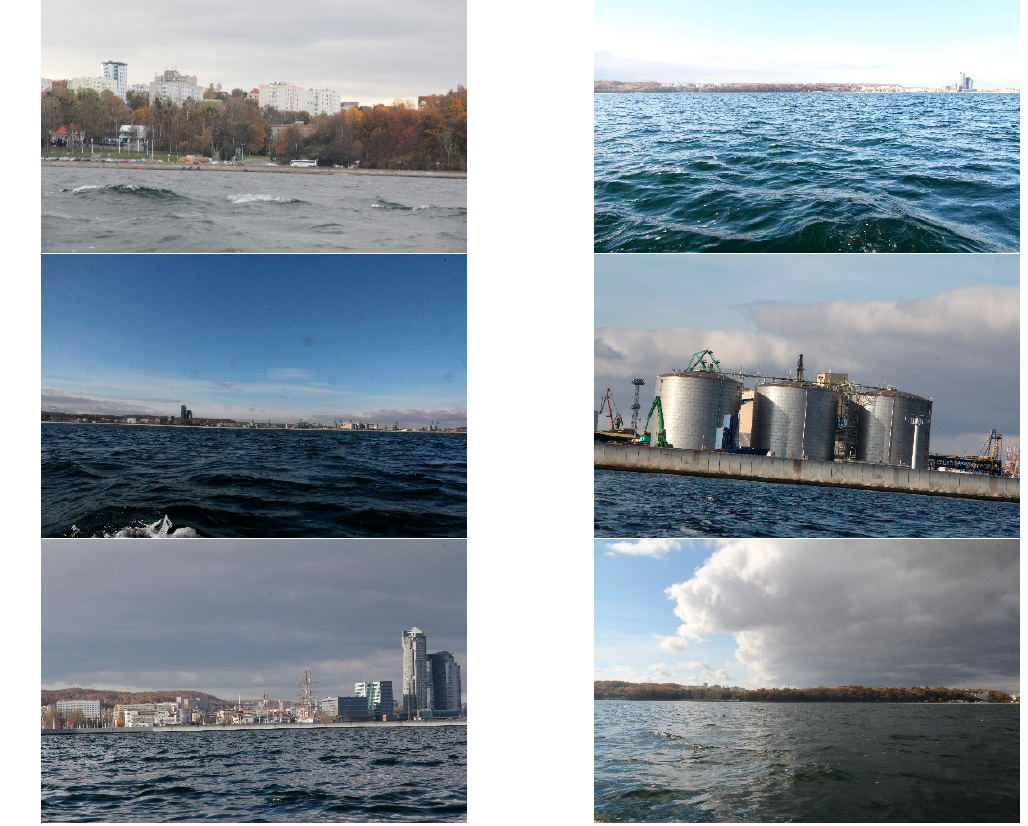
Figure 10. Examples of the images used during the experiment.